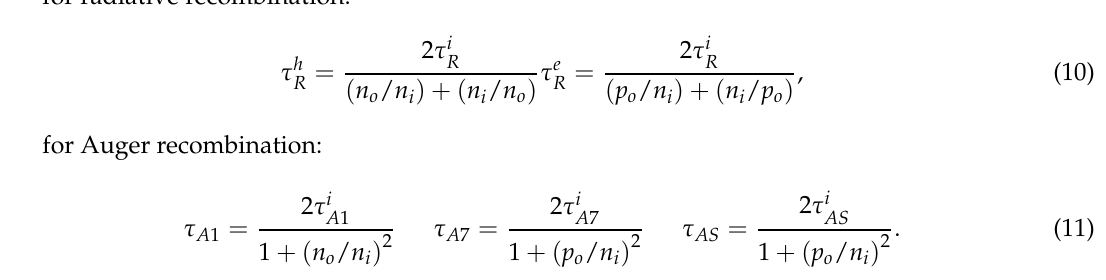
-3 Figure 19. Simulated minority carrier lifetime and diffusion length versus temperature for holes in n- type InAs 0.81 Sb 0.19 with doping levels 10 15 and 10 16 cm − 3 and τ SRH = 400 ns.